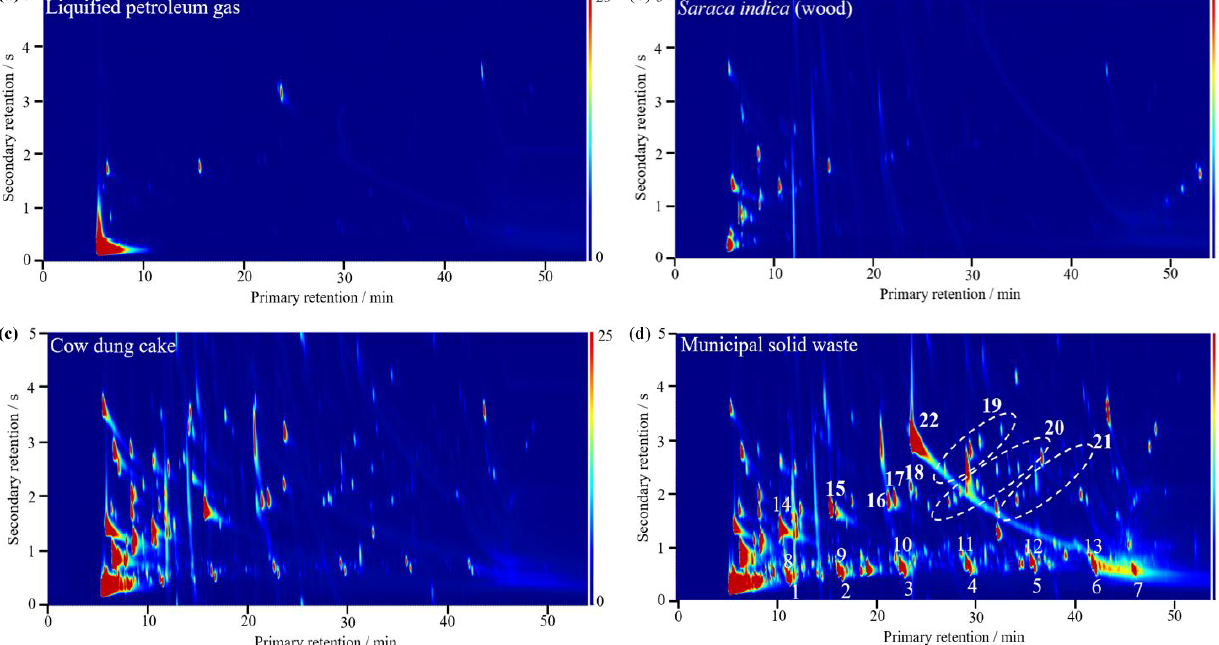
Figure 2. GC × GC-FID chromatograms from burning (a) LPG, (b) Saraca indica (fuelwood), (c) cow dung cake and (d) municipal solid waste samples where 1–7 = n -octane to n -tetradecane, 8–13 = 1-octadecene to 1-tridecene, 14 = benzene, 15 = toluene, 16 = ethylbenzene, 17 = m/p -xylene, 18 = o -xylene, 19 = C 3 -substituted monoaromatics, 20 = C 4 -substituted monoaromatics and 21 = C 5 -substituted monoaro- matics and 22 = styrene. Samples (a) – (d) were collected with the same sample collection parameters, and the chromatograms are set at the same contrast level to allow for direct comparison between different fuel